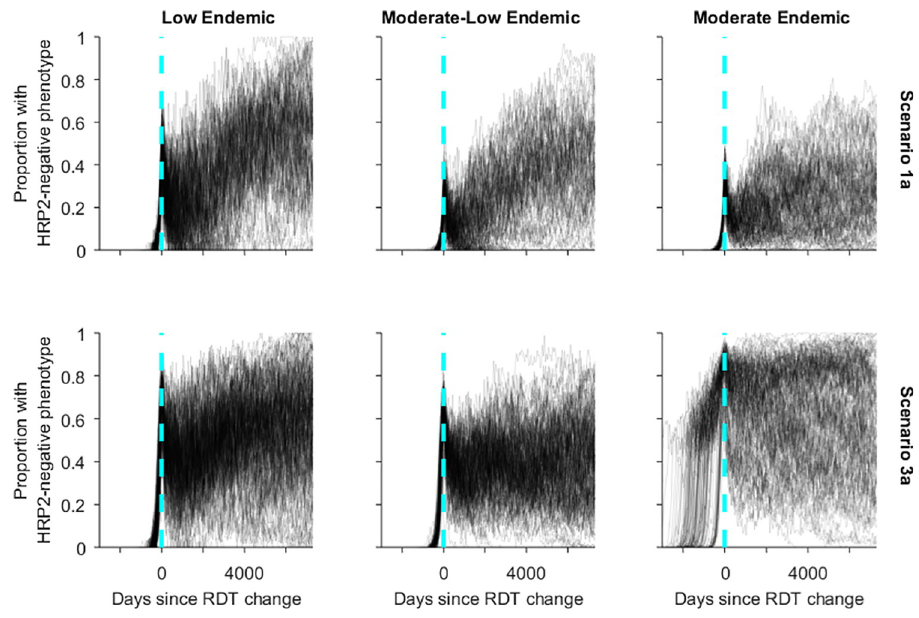
Fig 4. Simulation trajectories for the proportion of all asexual infections ( > 10 parasites/ μ L) with a HRP2-negative phenotype where 50% of symptomatic patients seek diagnosis and treatment and a Pf-LDH RDT is used after the RDT change. Vertical line represents RDT change day.